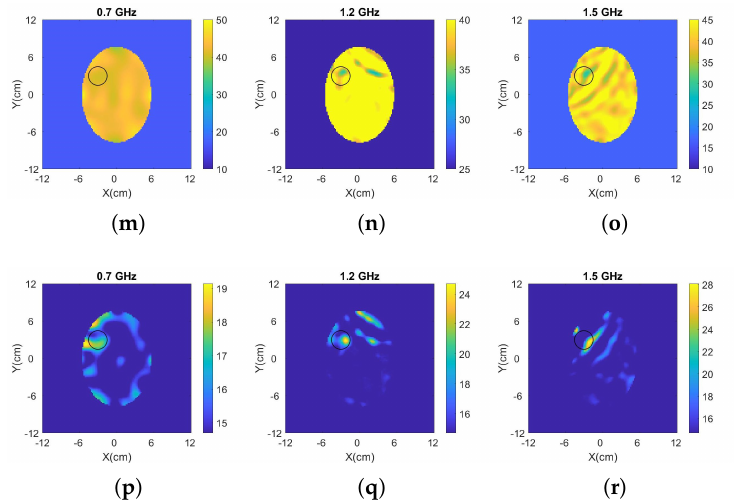
Figure 5. Results from single frequency reconstructions of the real (first, third and fifth line) and imaginary (second, fourth and sixth line) part of the complex permittivity for: ( a–f ) h-stroke, ( g–l ) 25% i-stroke and ( m–r ) 50% i-stroke.